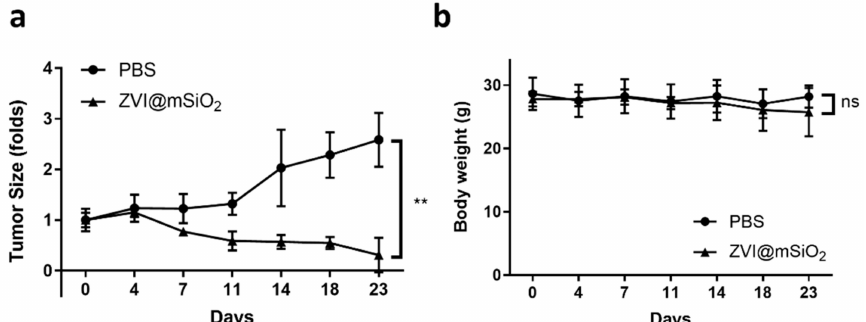
Figure 6. ZVI@mSiO 2 NPs showed anticancer activity in vivo and had no significant e ff ect on mice body weight. ( a ) The tumor growth curve showed significant growth inhibition in the ZVI@mSiO 2 NP-treated group ( P = 0.0029, Student’s t -test) within a month. ( b ) The body weight curves showed no significant di ff erences between PBS- and ZVI@mSiO 2 NP-treated groups ( P = 0.0824, Student’s t